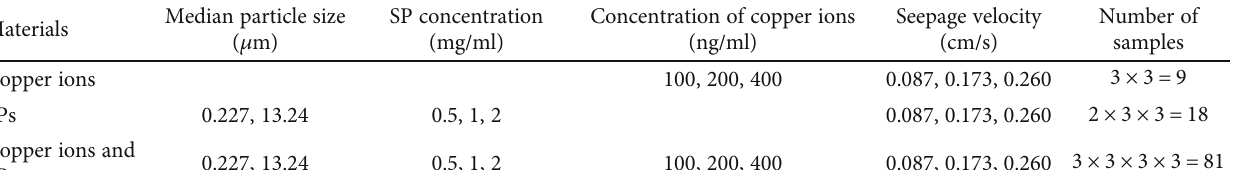
Table 1: Schemes.